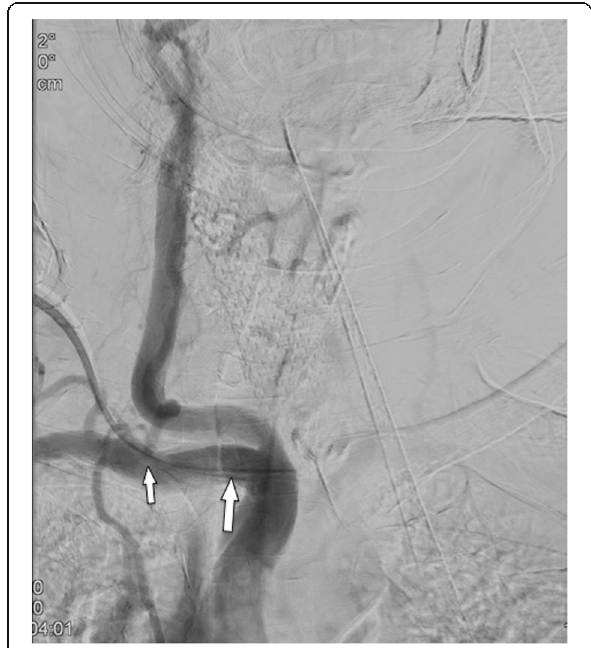
Fig. 5 Arterial malpositioning of an interventionally placed port system. DSA shows placement into the subclavian artery close to the origin of the vertebral artery